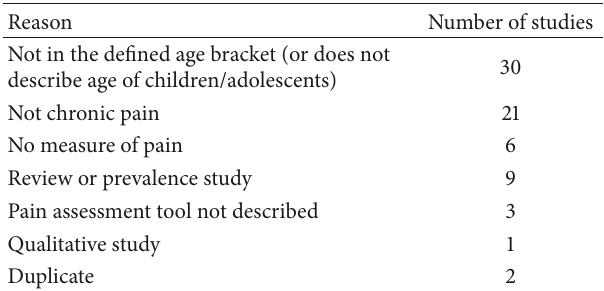
Table 2: Reasons for exclusion of studies after full-text review of